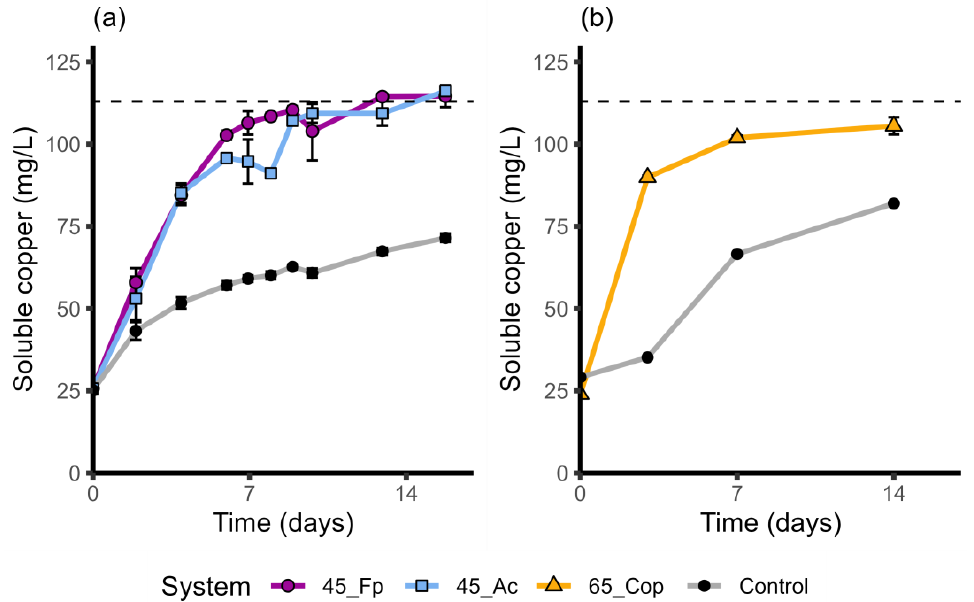
Figure 6. Copper recovery during bioleaching assays at 45 ( a ) and 65 °C ( b ). Sterile controls performed in MAC medium using a sterilized mineral and paraformaldehyde were included at both temperatures.